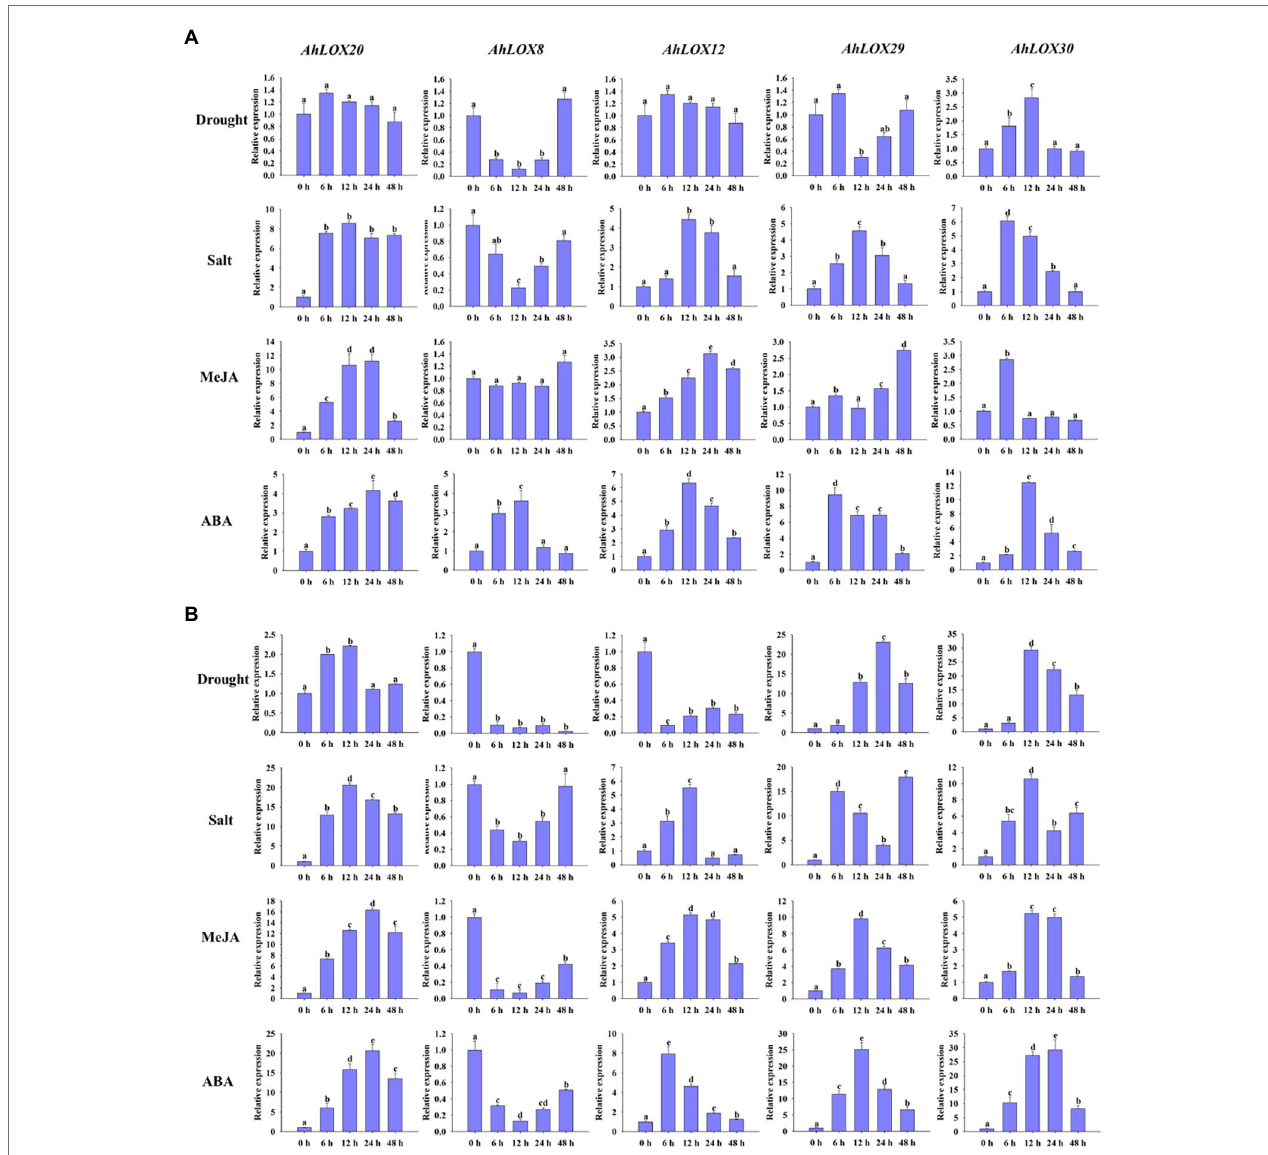
FIGURE 9 | Analysis of the relative expression levels of peanut LOX genes by qRT-PCR. The expression profiles of five peanut LOX genes ( AhLOX20 , AhLOX8 , AhLOX12 , AhLOX29 , and AhLOX30 ) under two stresses (drought and salt) and two hormone treatments (MeJA and ABA) were validated. (A) Leaves; (B) Roots. The data are presented as the mean ± SD ( n = 3), and the values differed significantly at p < 0.05. The different letters indicate significant